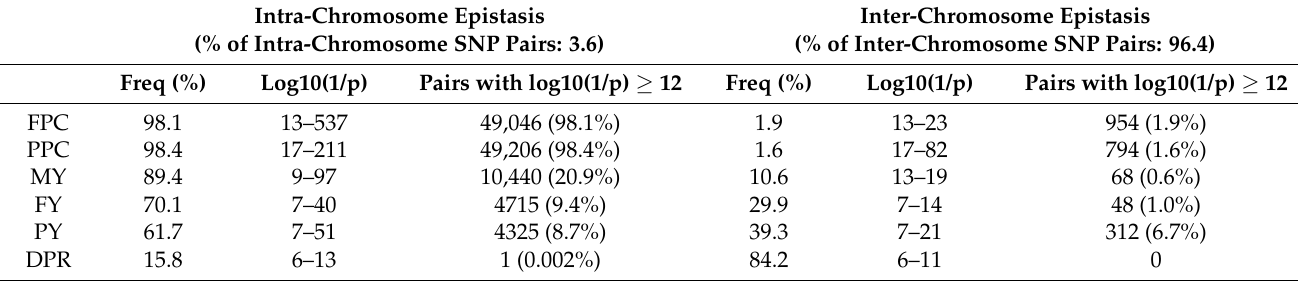
Freq = frequency. FPC = fat percentage. PPC = protein percentage. MY = milk yield. FY = fat yield. PY = protein